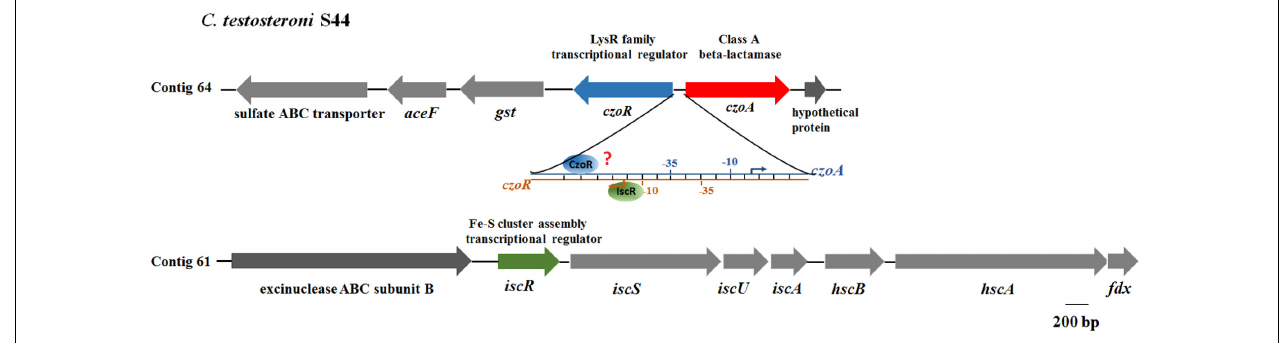
FIGURE 1 | Genetic organization of czoR and iscR. The czo R and czo A genes form a divergent operon ( czoR – czoA ) located in contig 64. The isc operon of S44 is composed of the iscRSUA – hscBA – fdx genes and is located in contig 61. The diagram shows that both IscR and CzoR can bind to the czoR–czoA intergenic region, but the precise binding sites of CzoR are unknown. The –35 and –10 sequences were predicted using Softberry BPROM webtool (Solovyev and Salamov, 2011).